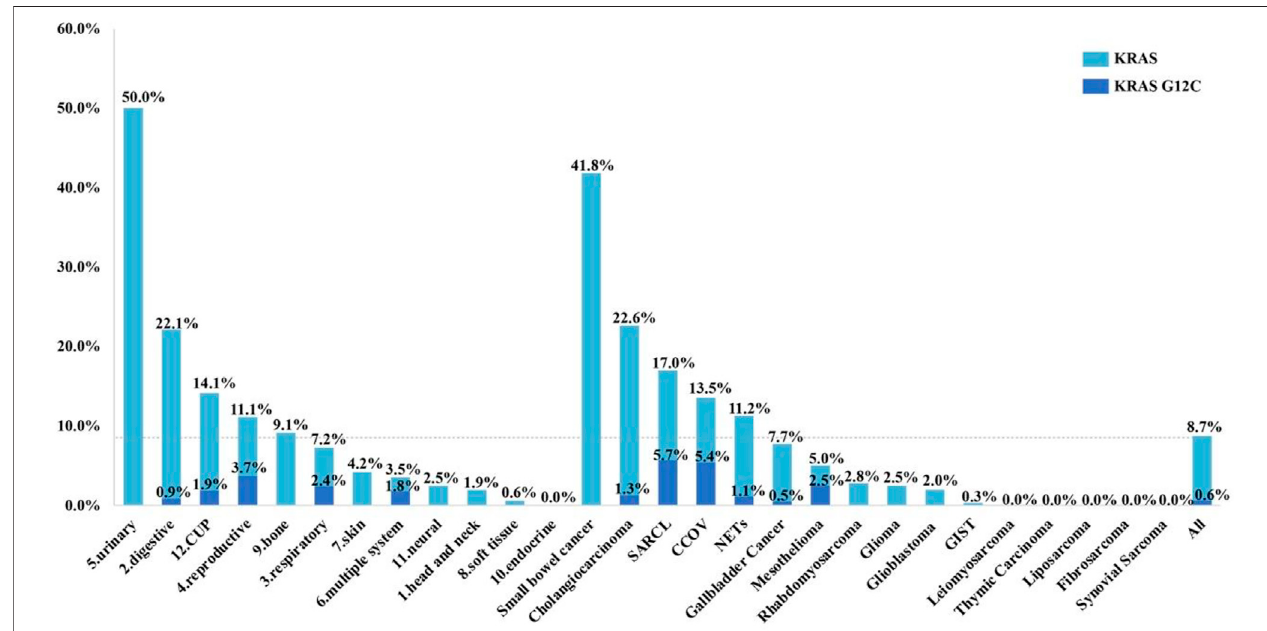
FIGURE 1 | Prevalence of KRAS mutations and KRAS G12C in different systems and subtypes of rare tumors. Cancer of unknown primary, CUP; sarcomatoid carcinoma of the lung, SARCL; clear cell ovarian cancer, CCOV; neuroendocrine tumors, NETs; gastrointestinal stromal tumor, GIST.